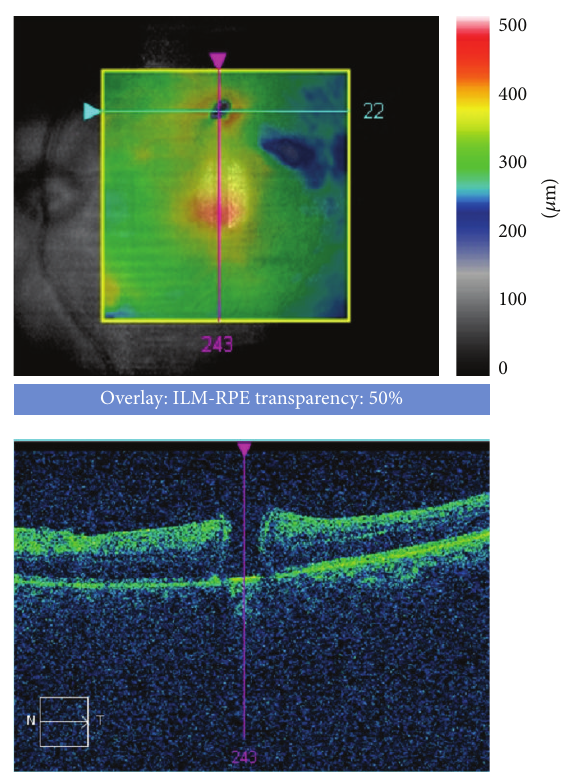
Figure 2: Parafoveal iatrogenic macular hole 1 week after ILM peeling for a full-thickness macular hole